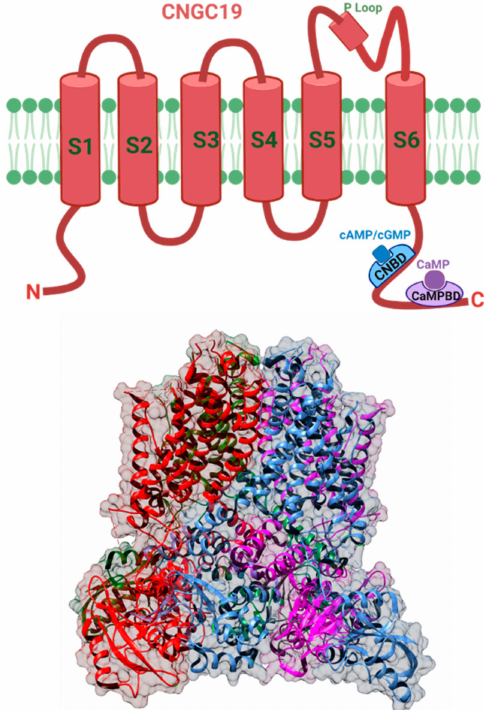
Figure 3. Putative structure of CNGC19 channel. (Top) Schematic cartoon representation of CNGC19 channel subunit showing six membrane-spanning regions (S1–S6) and a large pore domain (S5–S6). Functionally relevant sites in the C -terminus consist of a CNB, cyclic nucleotide-binding domain which can bind cAMP/cGMP, and a CaMBD, calmodulin-binding domain which can bind calmodulin. The functional channel is formed by four subunits. (Bottom) The structure of CNGC19 has not been solved to date but is likely to show similarities with the animal CNG family of channels. Therefore, the structure shown in the figure is an approximation based on homology to other channels. The predicted CNGC19 secondary 3D structure model, showing four subunits in transparent surface view, was developed from the closest homolog PDB structure, 5VA1 (human ether-a-go-go related K + channel) using PHYRE 2.0 program. The image was prepared using Chimera software [122]. Created with BioRender.com (accessed on 30 August